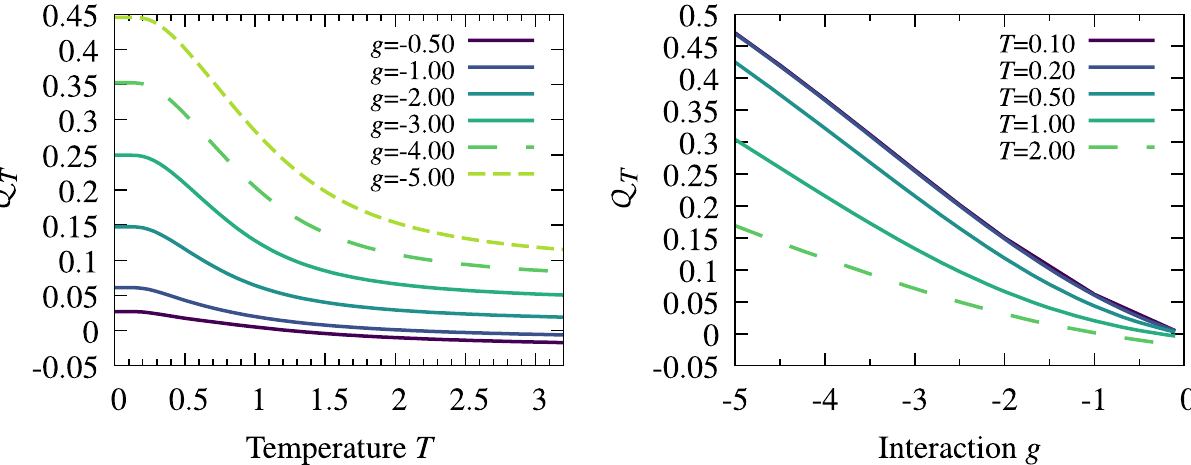
8 particles as a function of temperature =